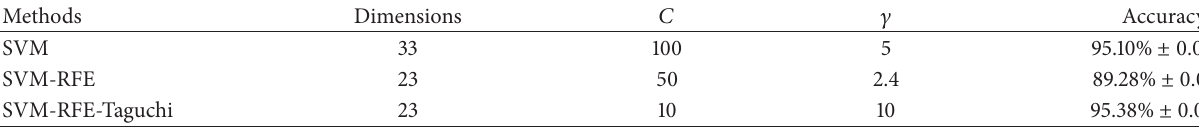
Table 9: Classification performance comparison of Dermatology database.